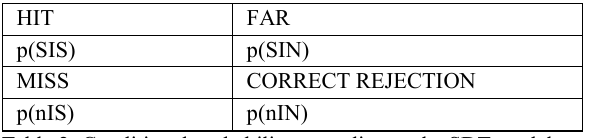
Table 2: Conditional probability according to the SDT model.